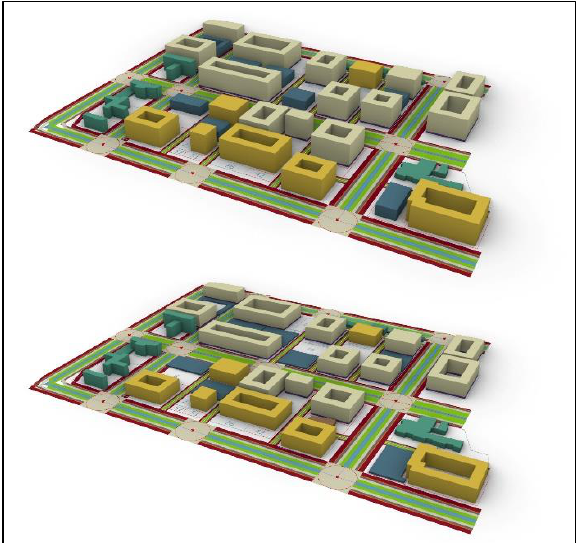
Figure 15. [Top] 3D model generated in Sloterdijk One using the Elandsgrachbuurt space sizes as reference. [Bottom] The same model generated using the Orteliusbuurt space